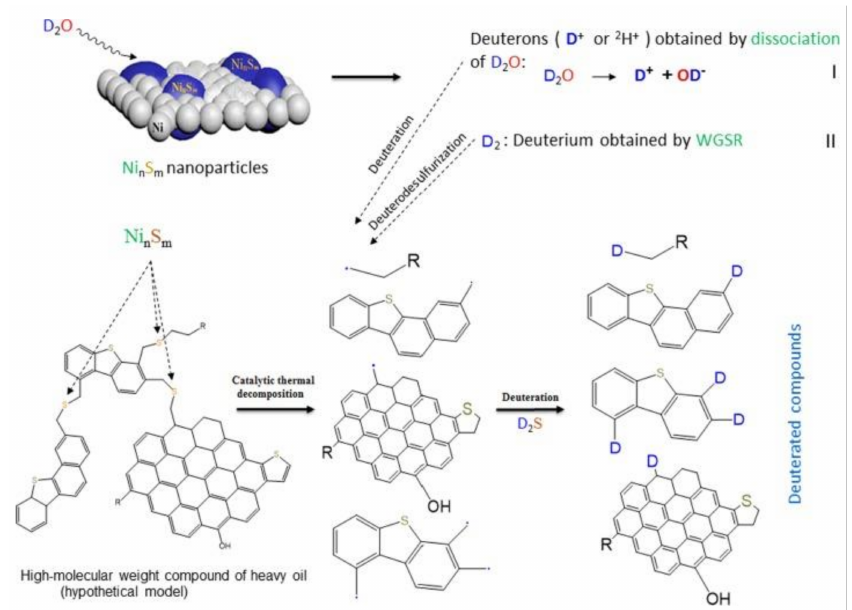
Figure 3. Deuterium generation in the presence of Ni n S m nanoparticles during thermal cracking of heavy oil molecules.